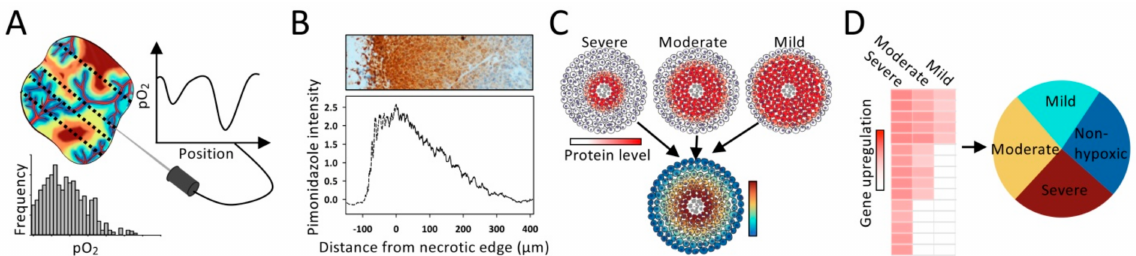
Figure 3. Invasive methods for quantification of hypoxia levels. ( A ) Polarographic needle electrodes for recording of pO 2 along tracks in a tumor. Frequency distribution of recorded pO 2 values is indicated. ( B ) Pimonidazole staining intensity in a histologic section from a xenograft tumor vs. distance from necrosis (below). The histologic section is shown above. (From “MRI Distinguishes Tumor Hypoxia Levels of Different Prognostic and Biological Significance in Cervical Cancer”. by Hillestad, T.; Hompland, T.; Fjeldbo, C.S.; Skingen, V.E.; Salberg, U.B.; Aarnes, E.-K.; Nilsen, A.; Lund, K.V.; Evensen, T.S.; Kristensen, G.B.; et al. 2020, Cancer Res., 80, 3993–4003, Copyright 2020 by American Association for Cancer Research [27]). ( C ) Spheroids indicating proteins upregulated at different hypoxia levels (above), and the combined expression data (below). ( D ) Gene expression signatures associated with defined hypoxia levels (left), and pie chart showing fractions of tumor with the defined level (right). ( A , C , D ) Hypoxia levels are indicated by the color code, with approximate oxygen concentrations (% O 2 ) and tensions (mmHg) provided by the x -axis in Figure